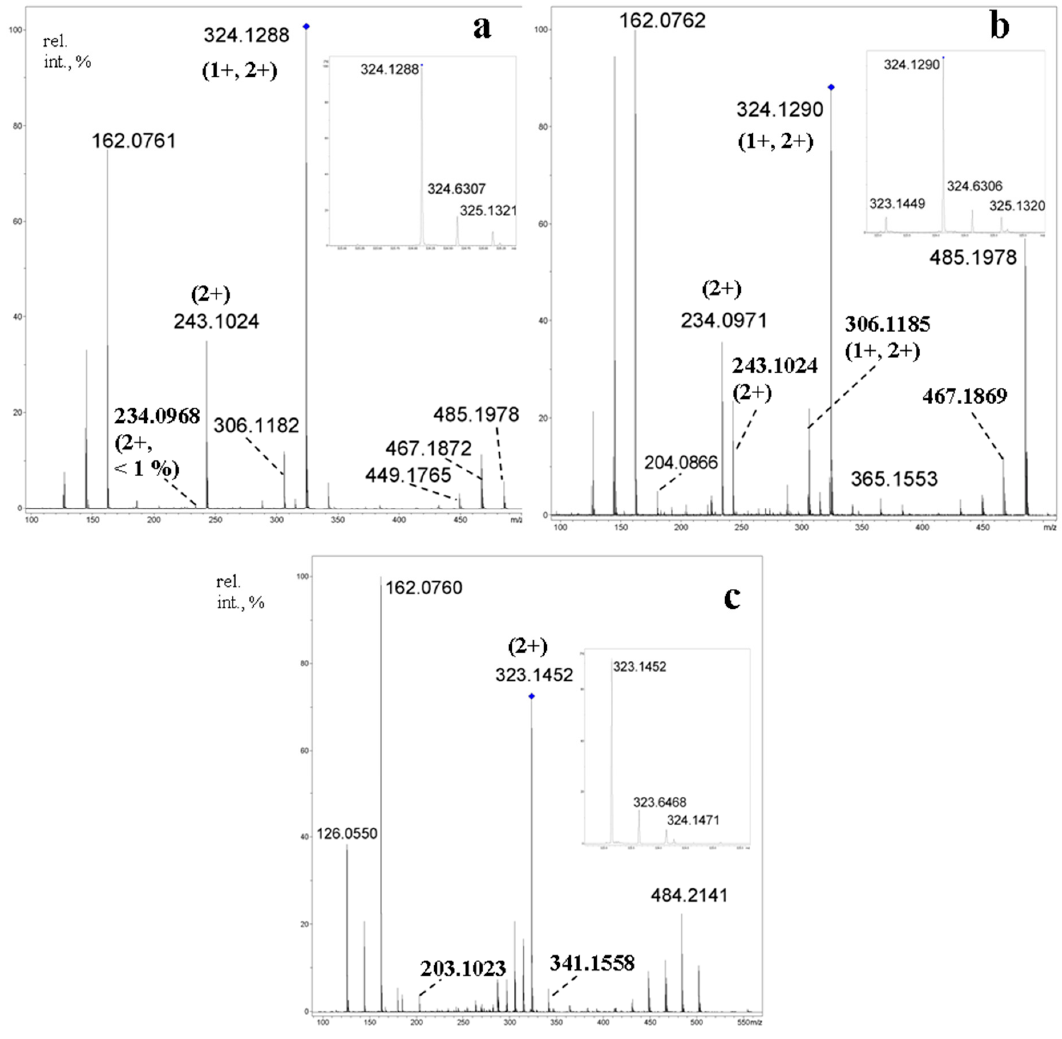
Figure 20. CID MS 2 of [M + 2H] 2 + ions for cyclotetrasaccharides 25 ( a ); 26 ( b ) and, for comparison, 21a ( c ) ( m / z 324.1 (a) and (b), m / z 323.1 (c), activation energy 10 eV). The characteristic peaks m / z 323 and m / z 324 are given in insets [71].